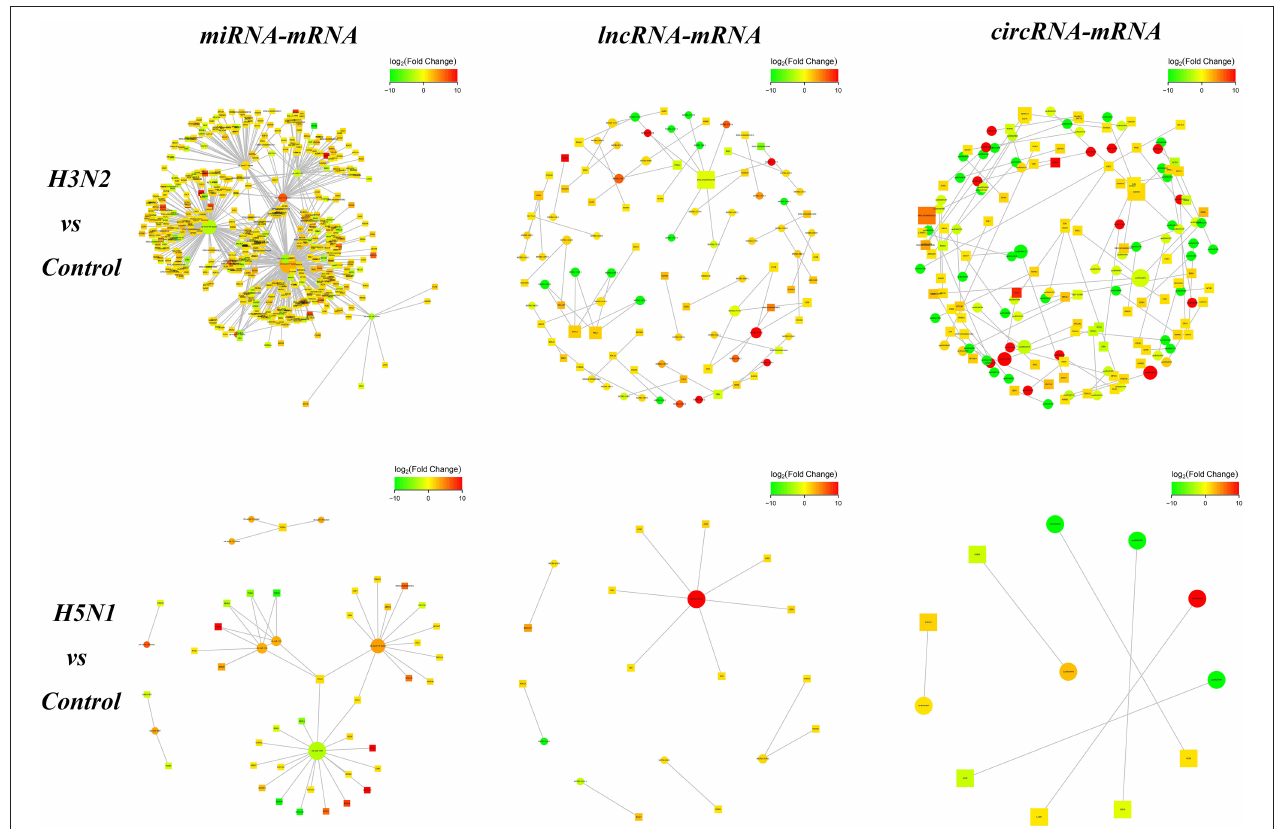
FIGURE 3 | The network diagram of ncRNA and mRNA interactions. Square nodes indicate ncRNAs, round nodes indicate mRNAs, and the edges indicate the interactions between the two genes. The size of the node is proportional to the connectivity (degree) of the node; namely, the more edges are connected to the node, the larger the degree of the node, indicating that the gene is more important in the network. The color of the node represents the difference in gene expression in this group of samples, namely, the logFC value; green represents downregulation, red represents upregulation, and the color depth represents differences in the altered